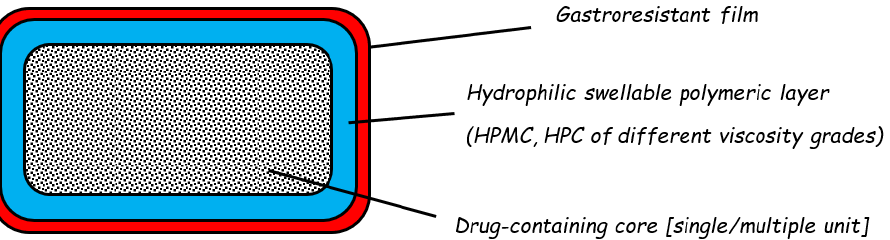
Figure 14. Schematic representation of the Chronotopic ® system. Adapted with permission from Ref. [58]. 2009, John Wiley & Sons.